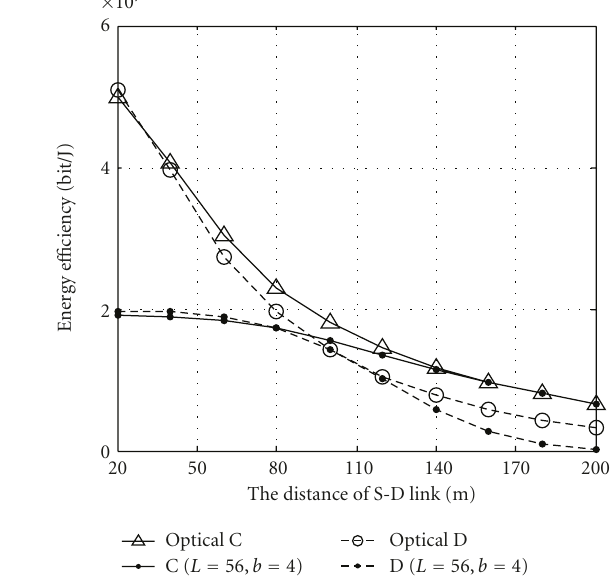
Figure 5: Energy e ffi ciency versus the S-D distance for optimal and nonoptimal scenarios.